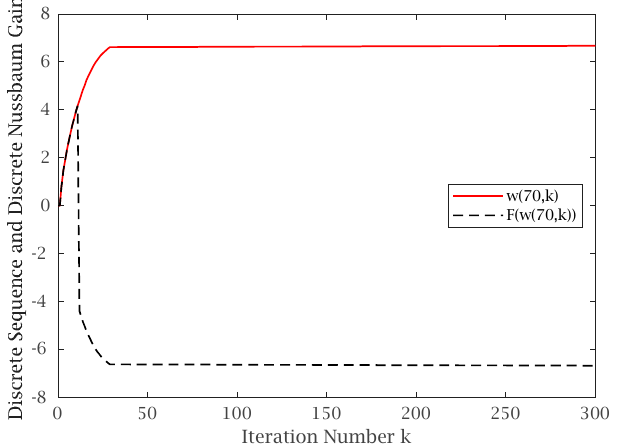
Figure 4. Discrete sequence { w ( t , k ) } and discrete Nussbaum gain sequence { F ( w ( t , k ))} at t = 70. The iterative tracking error index EE ( k ) under different iterations is plotted in Figure 5. We can find that at the beginning of the iteration, the error index EE ( k ) increased significantly due to the control direction of the system (31) has not been correctly judged. After the control direction of the system (31) is correctly identified, the iterative tracking error index EE ( k ) begins to decrease. Figures 4 and 5 validate that the discrete Nussbaum gain F ( w ( t , k )) can modify the sign accordingly to accommodate the unknown control direction, and show the effect of the Nussbaum gain function to efficiently identify the right control direction. Figure 6 exhibits the system output y ( t , k ) and the reference trajectory y o ( t , k ) at 100th and 200th iterations, respectively. It can be observed that the system output y ( t , k ) can track the reference trajectory y o ( t , k ) as the iteration increase. Figure 7 shows u ( t , k ) and 𝜏 ( t , k ) of the input saturation (32) at t = 70. Figure 8 exhibits the corresponding estimation of ω (cid:3549) ( t , k ) and W (cid:3553) ( t , k ) when t = 70.